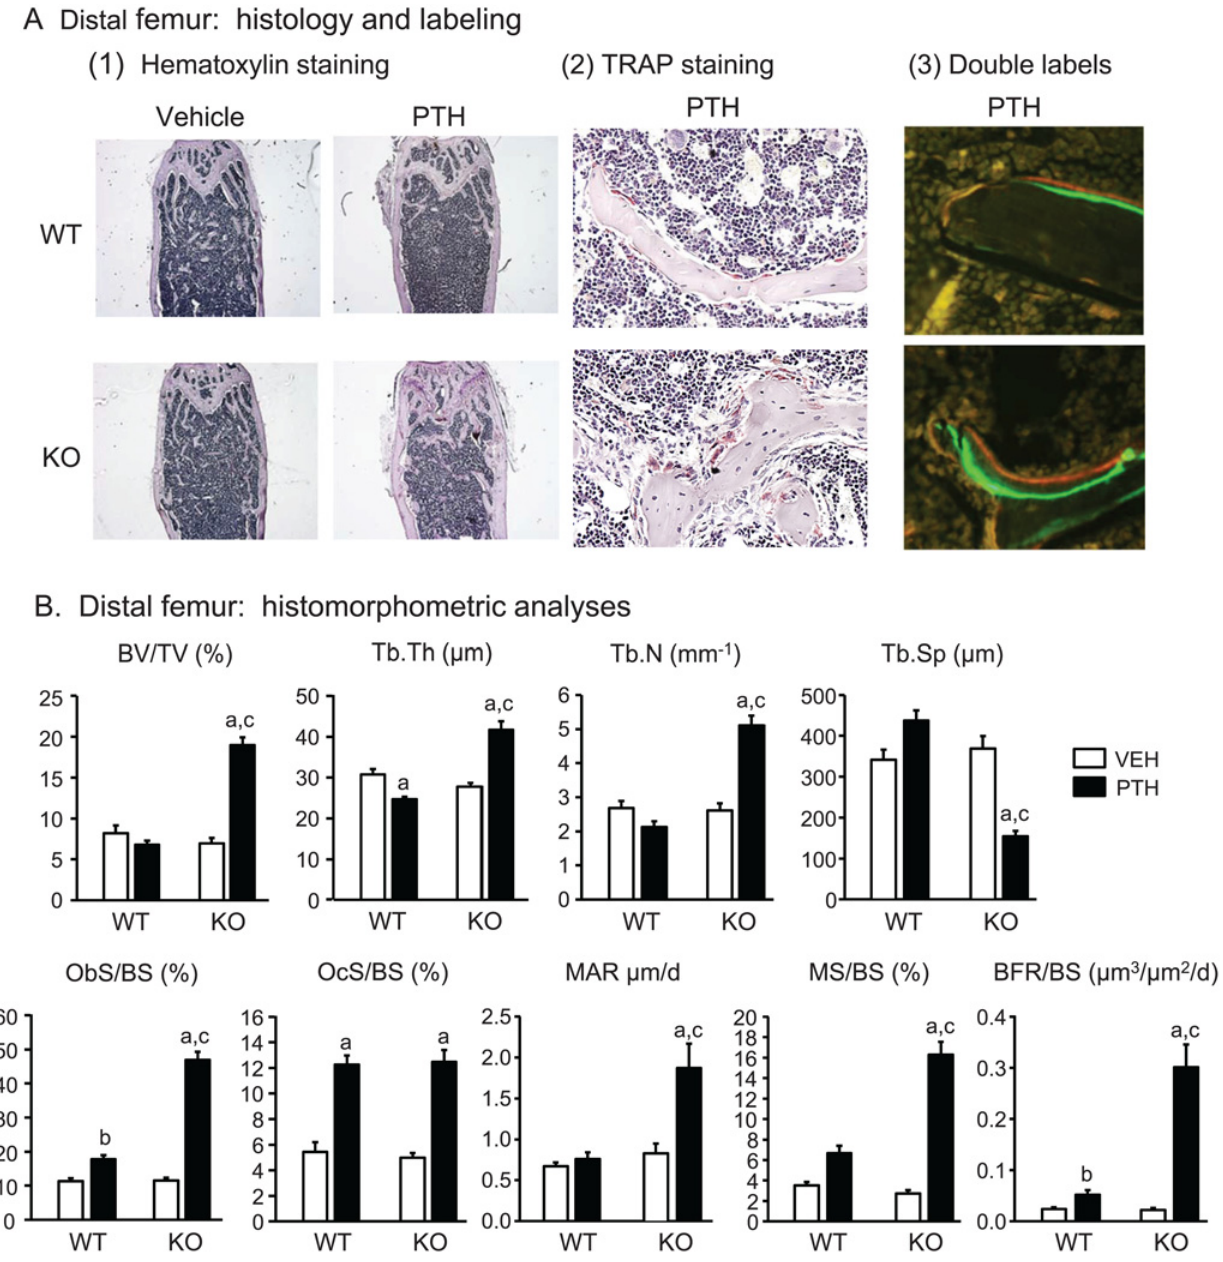
Fig 3. Static and dynamic histomorphometric analysis of distal femurs in mice infused for 12 days. A. Representative microscopic images of distal femur. (1) Hematoxylin staining at 20x magnification. (2) Tartrate resistant acid phosphatase (TRAP) staining and counter staining with hematoxylin at 400x magnification in PTH-infused WT and KO mice. (3) Double labeling with calcein (green) and demeclocycline (orange/brown) of trabeculae at 400x magnification in PTH-infused WT and KO mice. B. Histomorphometric analysis of distal femurs. Bars are means ± SEM for 7 WT and 7 KO mice treated with vehicle and 8 WT and 8 KO mice treated with PTH. a Significant effect of PTH, p < 0.01; b p < 0.05. c Significant effect of genotype, p < 0.01.